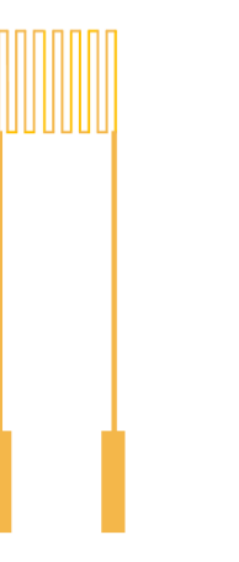
Figure 1. Schematic diagram of resistance temperature detector (RTD) structure.